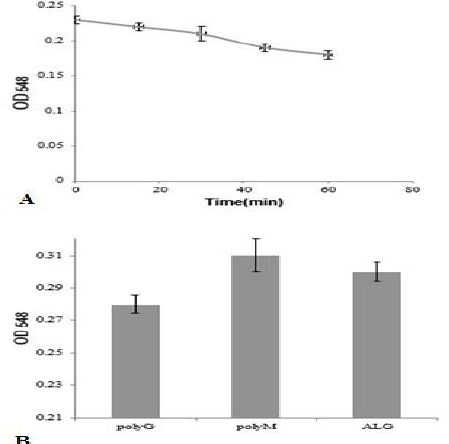
Fig. 1. Characterization of the enzyme-substrate relationship between alginate lyase ( AlgL) from P. aeruginosa strain 293 and its substrates. A) The effect of enzyme-substrate exposure time on enzyme activity. B) Substrate specificity of the AlgL. Guluronic acid blocks (PolyG), mannuronic acid blocks (PolyM) and compared with that of sodium alginate (ALG).